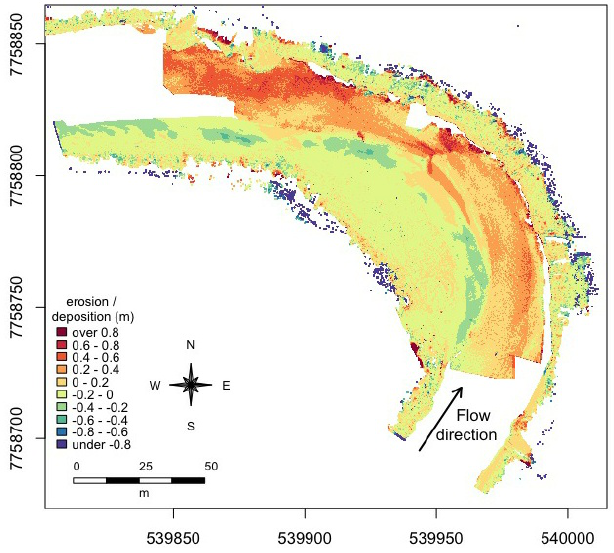
Figure 12. Difference map between 2010 and 2011 based on the contiguous models we produced. Orange and red colours indicate areas deposition; green and blue colours indicate areas of